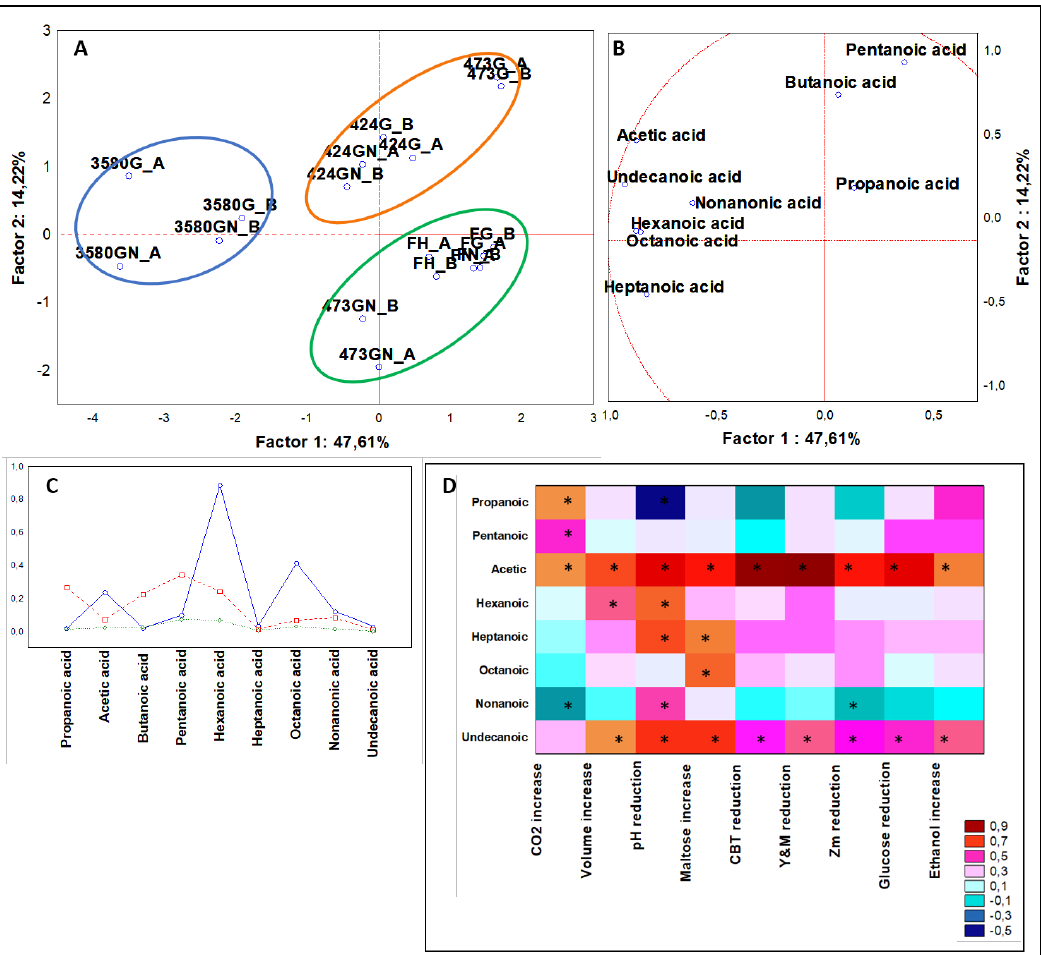
Figure 2. ( A ) PCA of cases and ( B ) variables on organic acids; ( C ) K-means clustering; ( D ) Spearman